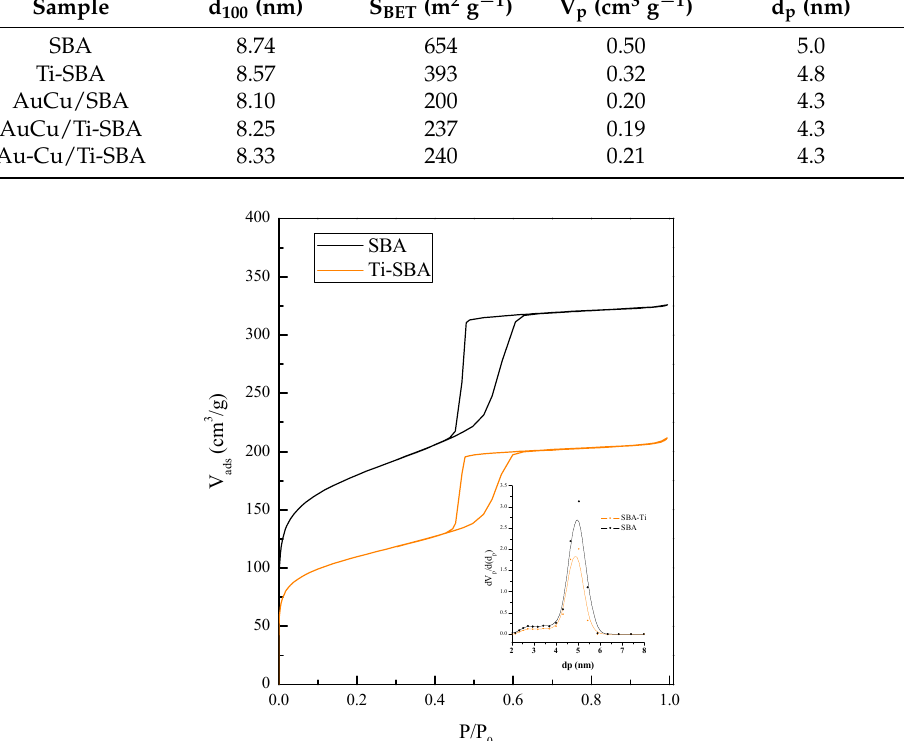
Figure 2. N 2 adsorption–desorption isotherms at − 196 °C of bare supports.